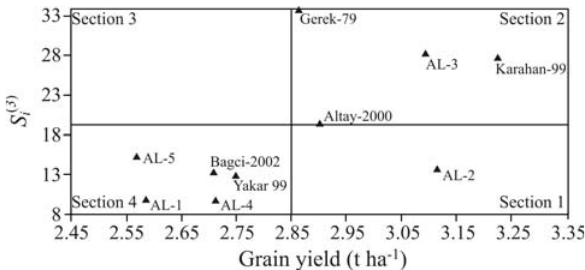
Figure3 -Plotofthesumoftheabsolutedeviationsofthesquaresofranks for each genotype ( S i ( 3 ) ) against mean grain yield ( gy , t ha -1 ) for 10 bread wheat genotypes over environments.